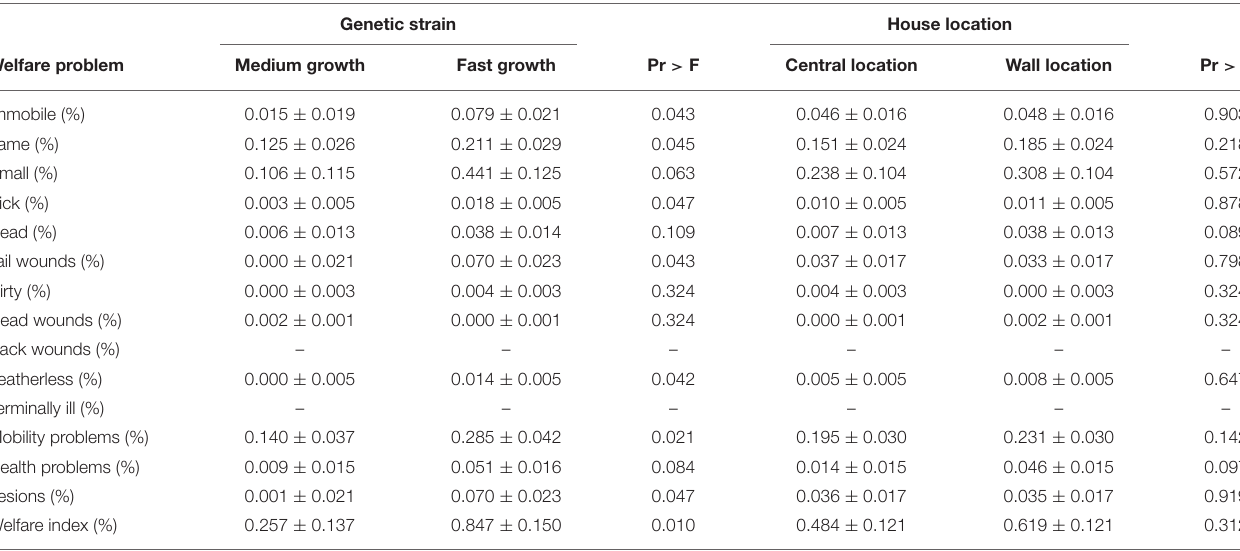
TABLE 1 | Effect (mean ± se) of broiler genetic strain (medium vs. fast growth broilers) and of the house location where welfare assessments were carried out (central vs. wall locations) on the occurrence of welfare problems/transect detected during welfare assessments.